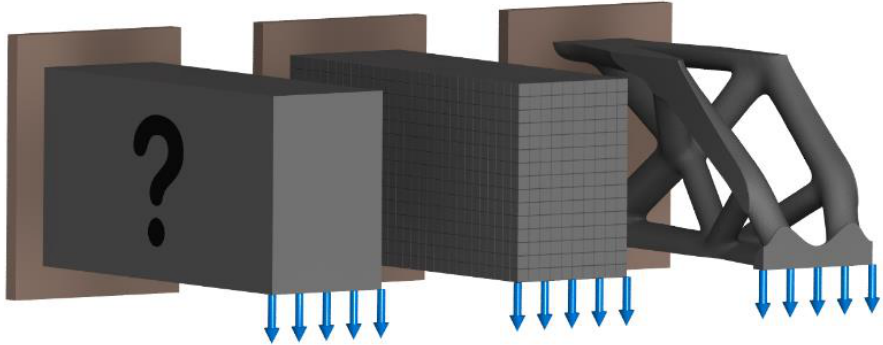
Figure 1. The process of structural design by means of topology optimization: (1) define the design problem; (2) discretize the design domain; and (3) optimize the structure’s topology to achieve an efficient design.